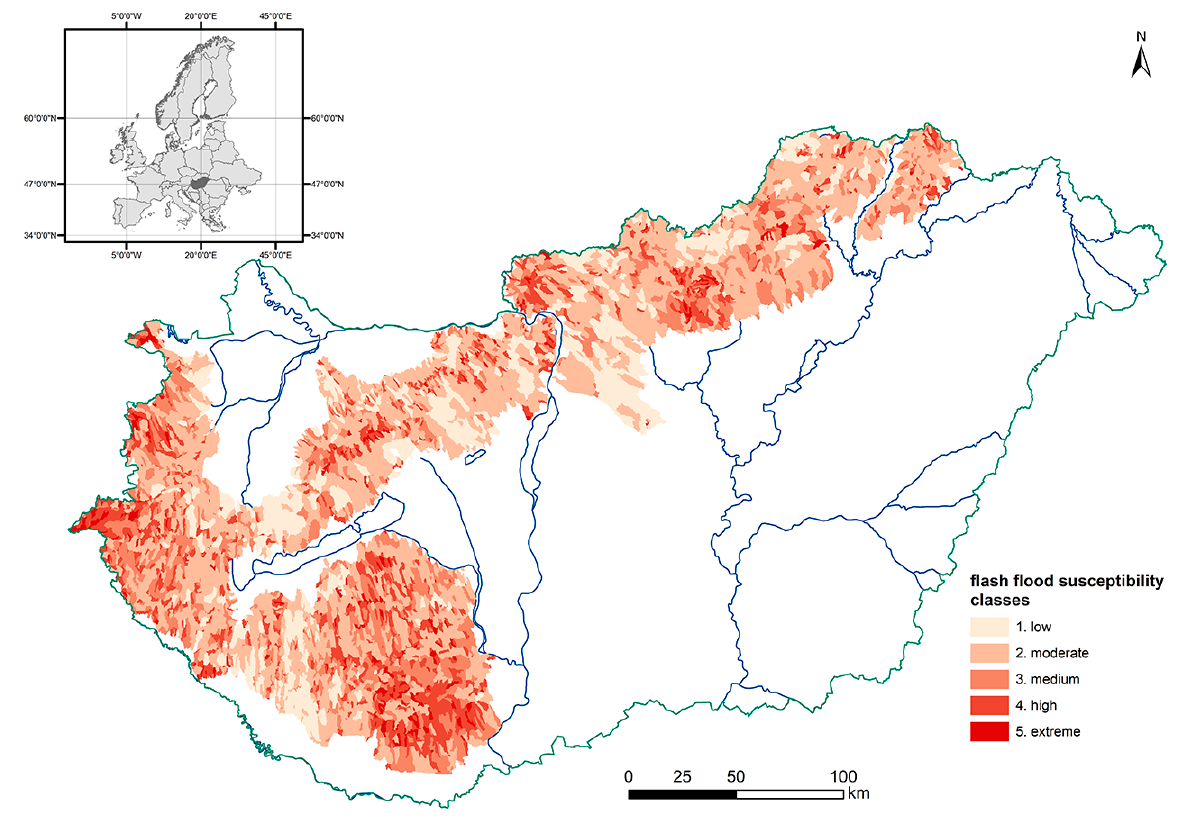
Figure 2. Elementary FFSI